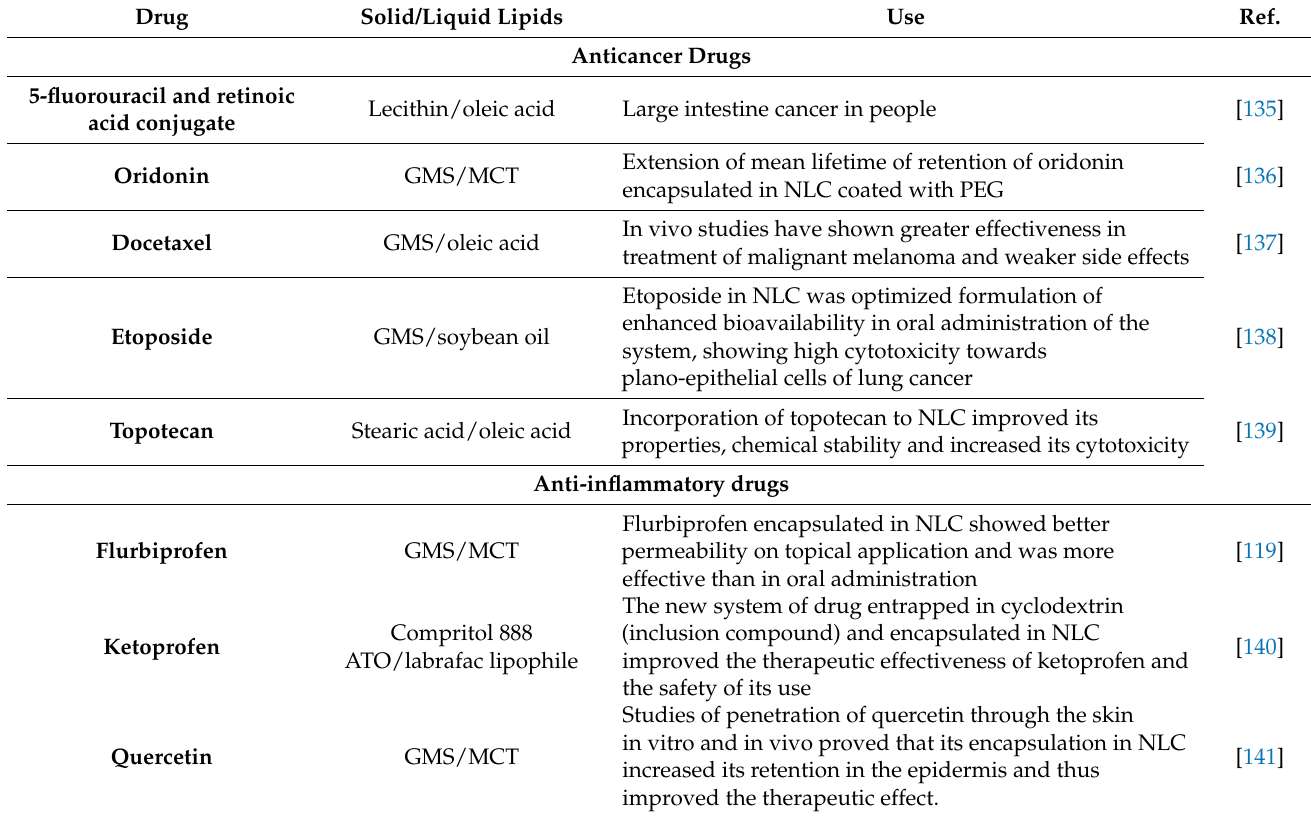
Table 6. Drugs used in the NLC delivery system and their